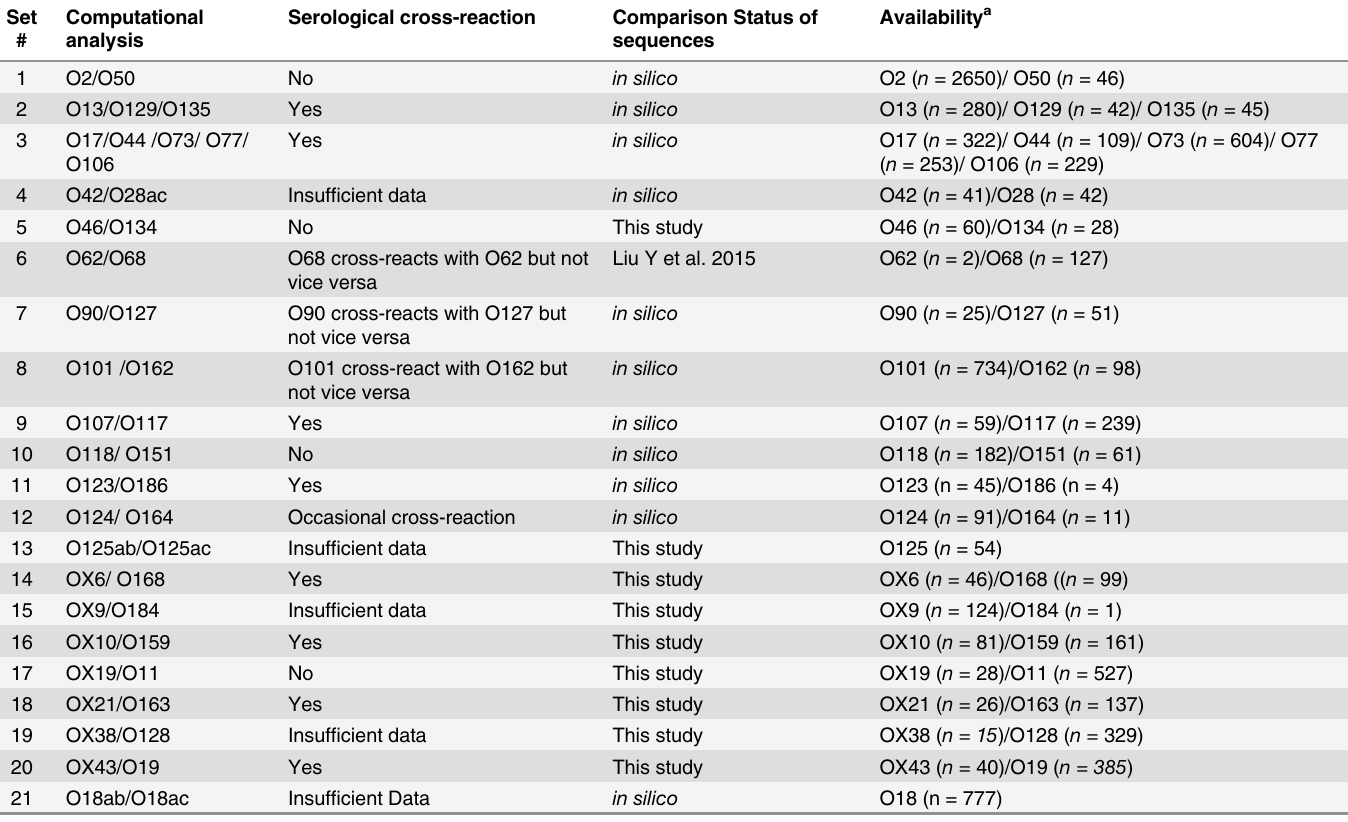
Table 1. Comparison of O-AGC of O-groups that are 98 – 99.9%